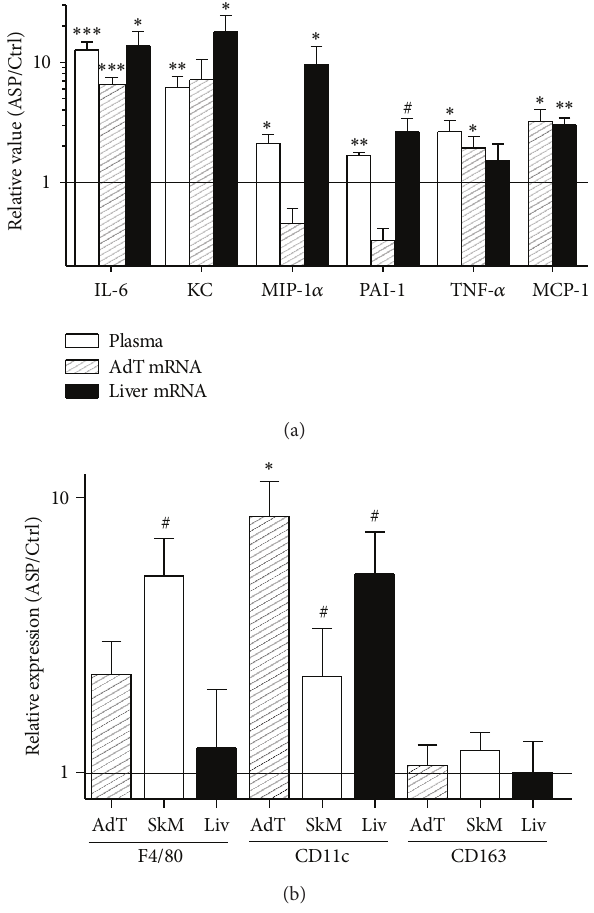
Figure 3: ASP induces proinflammatory effects in vivo . Relative plasma levels, adipose tissue, and liver mRNA content of several cytokines are shown in (a), for mice that were injected with ASP as compared to controls (PBS as vehicle). For the same animals, relative mRNA levels of total macrophages marker (F4/80), M1 macrophages marker (CD11c), and M2 macrophage marker (CD163) within adipose tissue, liver, and muscle are shown in (b). Results are expressed as relative concentration or expression compared with controls (vehicle) which are set as 1.0. Results are expressed as mean ± SEM where differences versus controls are expressed as # 𝑃 = 0.08 , ∗ 𝑃 < 0.05 , ∗∗ 𝑃 < 0.01 , and ∗∗∗ 𝑃 < 0.001 , with 𝑛 = 7-8 per